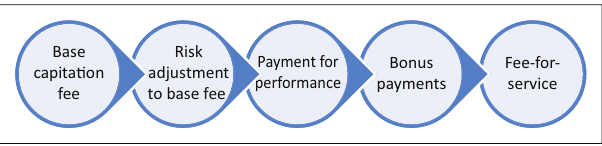
FIGURE 1: Determination of